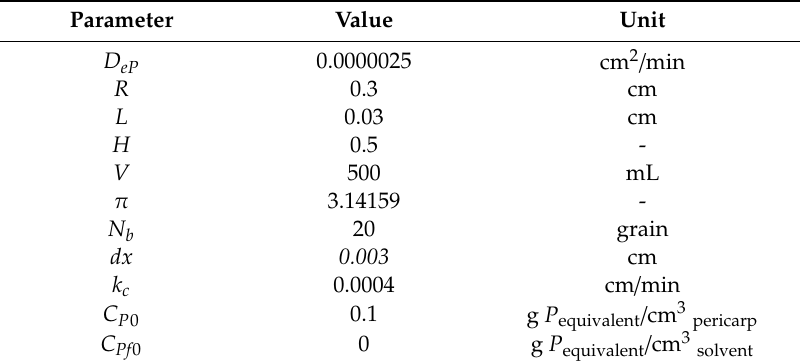
Table 1. The values of the parameters applied in the model’s